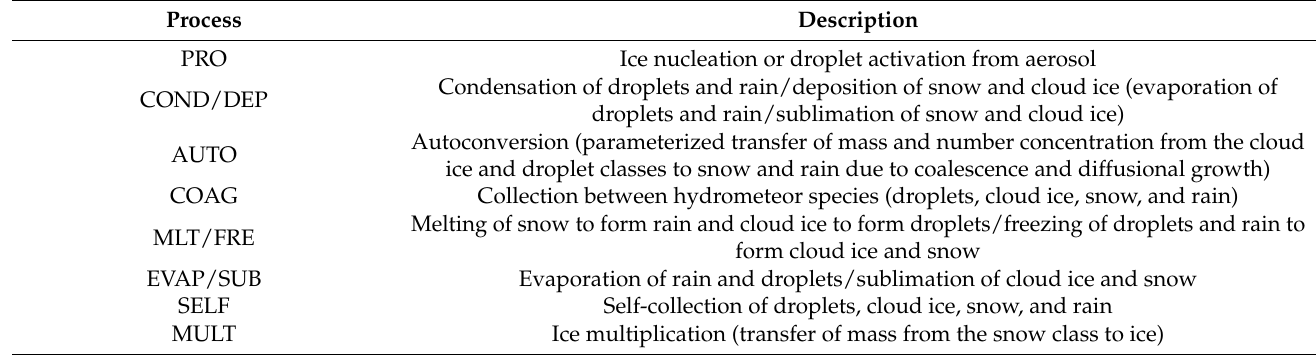
Table 2. The transformation processes in Equations (1) and